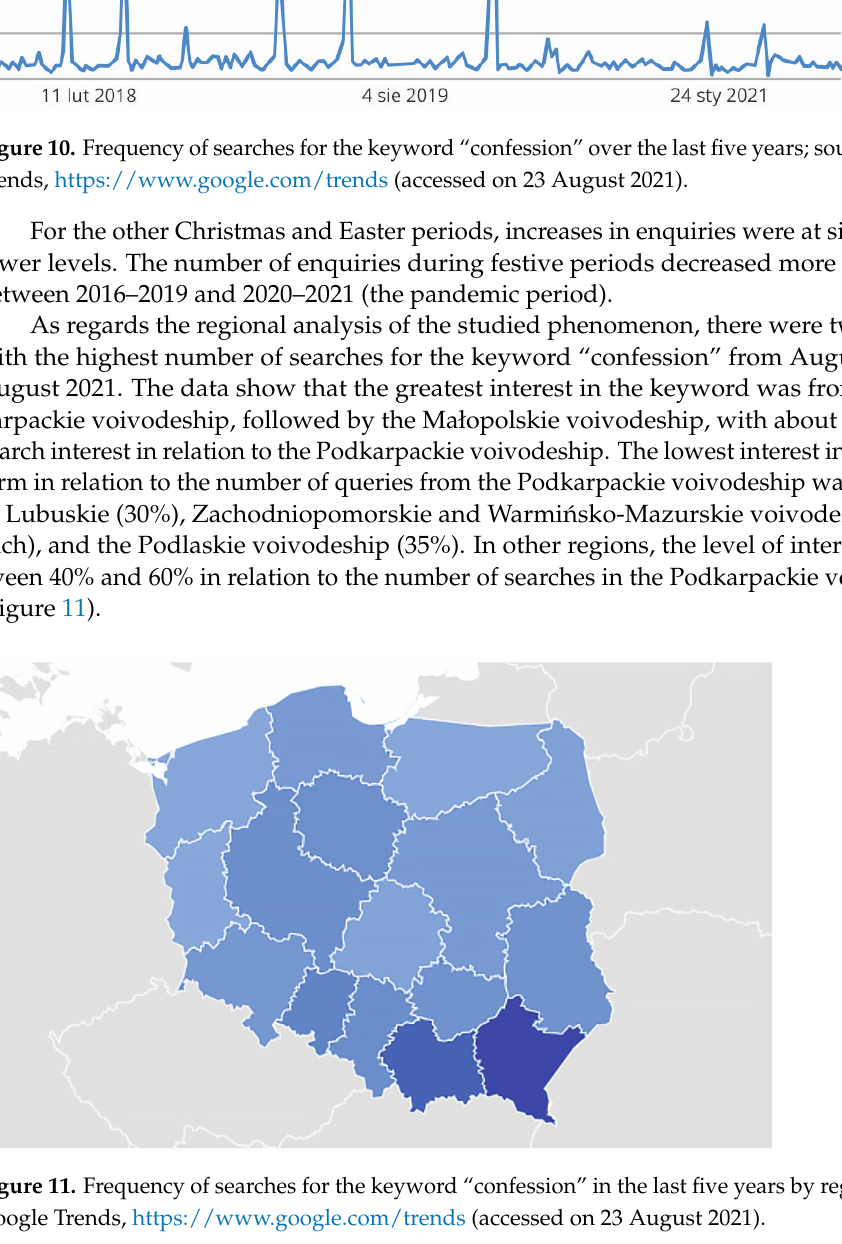
Figure 10. Frequency of searches for the keyword “confession” over the last five years; source: Google Trends, https://www.google.com/trends (accessed on 23 August 2021).